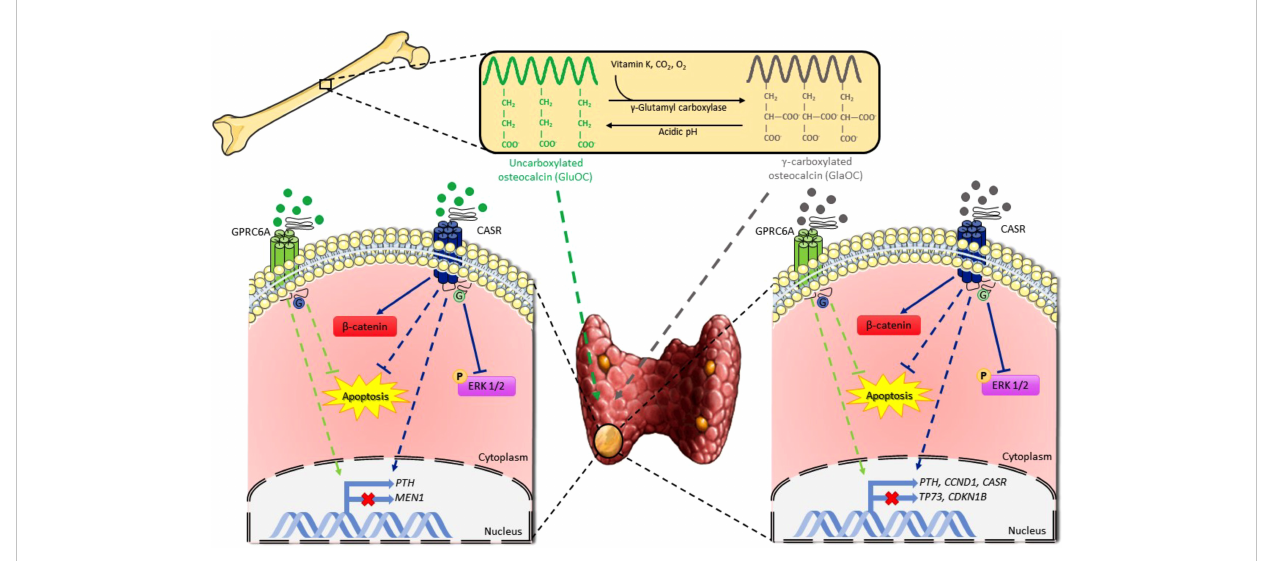
FIGURE 8 Schematic representation of osteocalcin effects on parathyroid tumor cell signaling pathways. GlaOC and GluOC, activating GPRC6A and CASR, modulate parathyroid gene expression and partially prevent apoptosis. GlaOC also reduces ERK phosphorylation and increases b -catenin mainly acting through CASR. Part of this fi gure was created using images from Servier Medical Art, licensed under a Creative Commons Attribution 3.0 Unported License